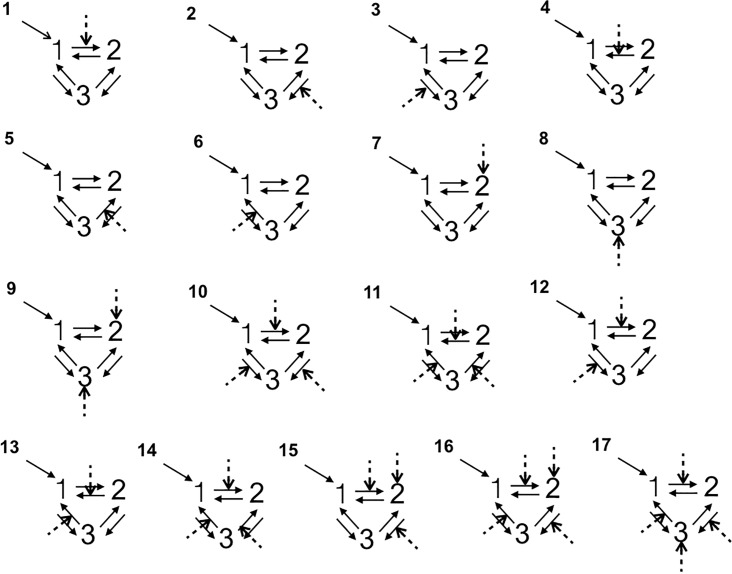
The models tested with Bayesian model selection.Numbers 1, 2, 3 refer to the regions of interest. The dashed lines indicate the modulatory influences of emotional acting on connectivity among right insula (rINS), left insula (lINS), and right/left MCC (MCC).